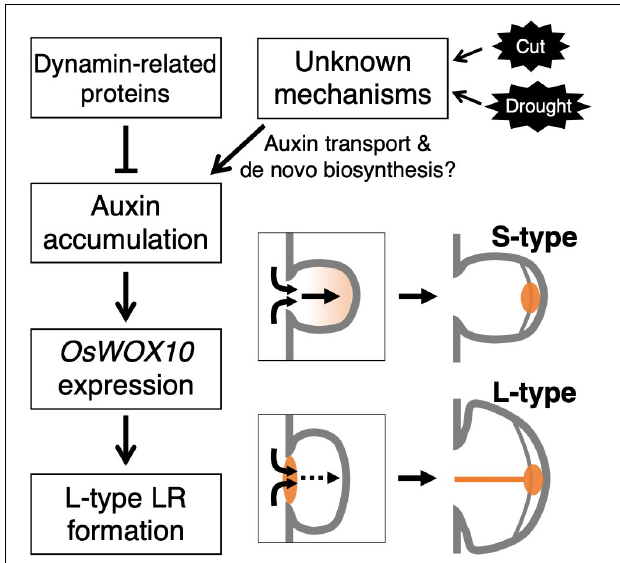
FIGURE 8 | Schematic model showing the regulation of lateral root primordium (LRP) size by auxin distribution. The mutations in genes encoding dynamin proteins resulted in the promoted L-type LR formation with auxin accumulation at basal part of LRP. The accumulated auxin induces a positive regulator of LRP size, OsWOX10 , promoting L-type LR formation. In the wild-type, unknown mechanisms might induce the auxin accumulation in LRP in response to the root tip excision (Cut) or drought